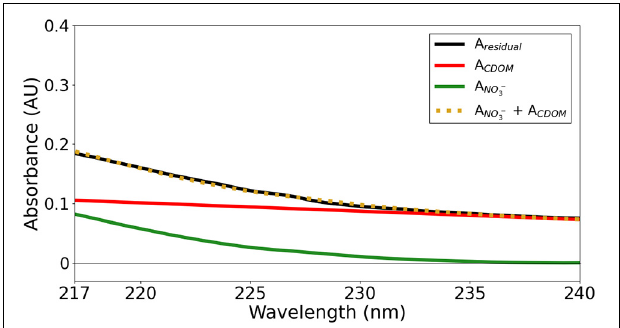
FIGURE 8 | The spectral signature of CDOM and NO 3 − within 217 and 240 nm (cNO 3 − = 19.4 µ M, S = 35.4, T = 13.6 ◦ C at 211 m depth during the M158-CTD71